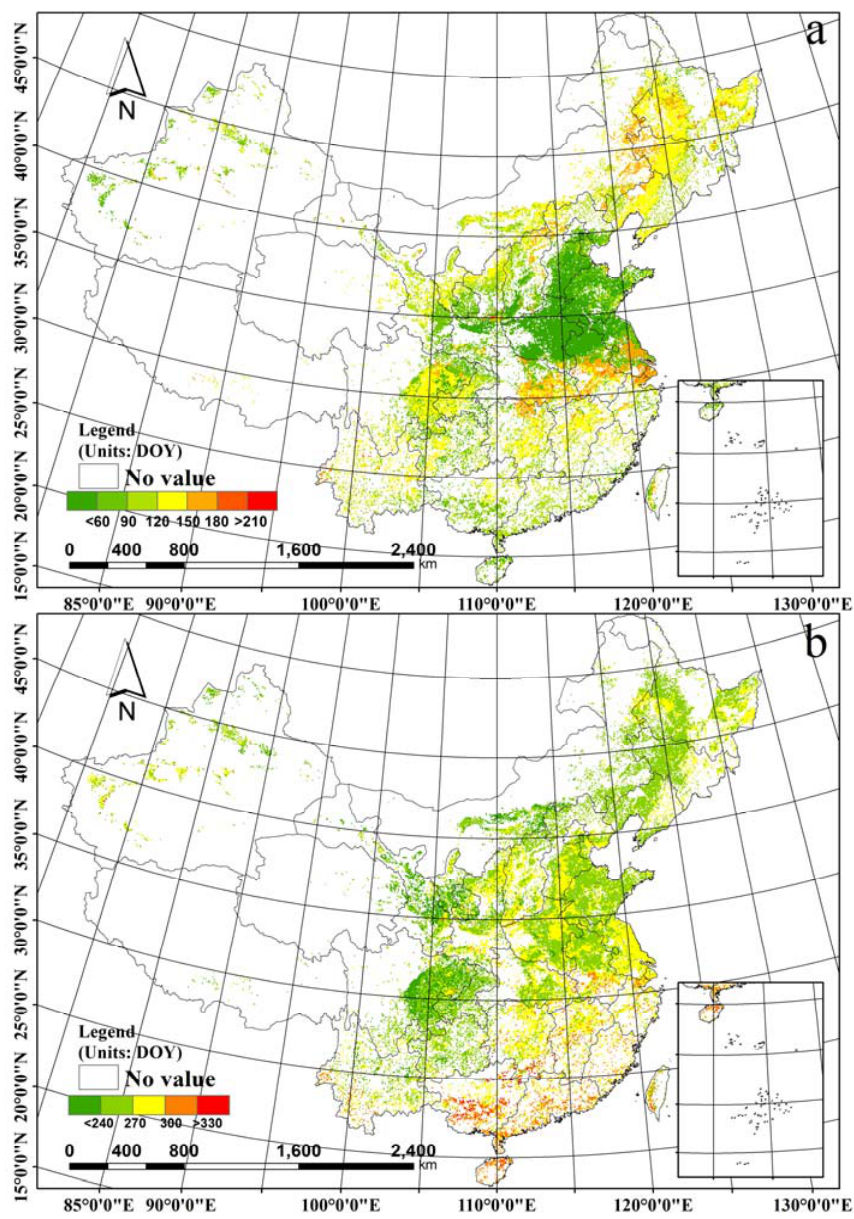
Figure 8. Maps of the ( a ) SOS; ( b ) EOS; and ( c ) LOS (DOY) in China,